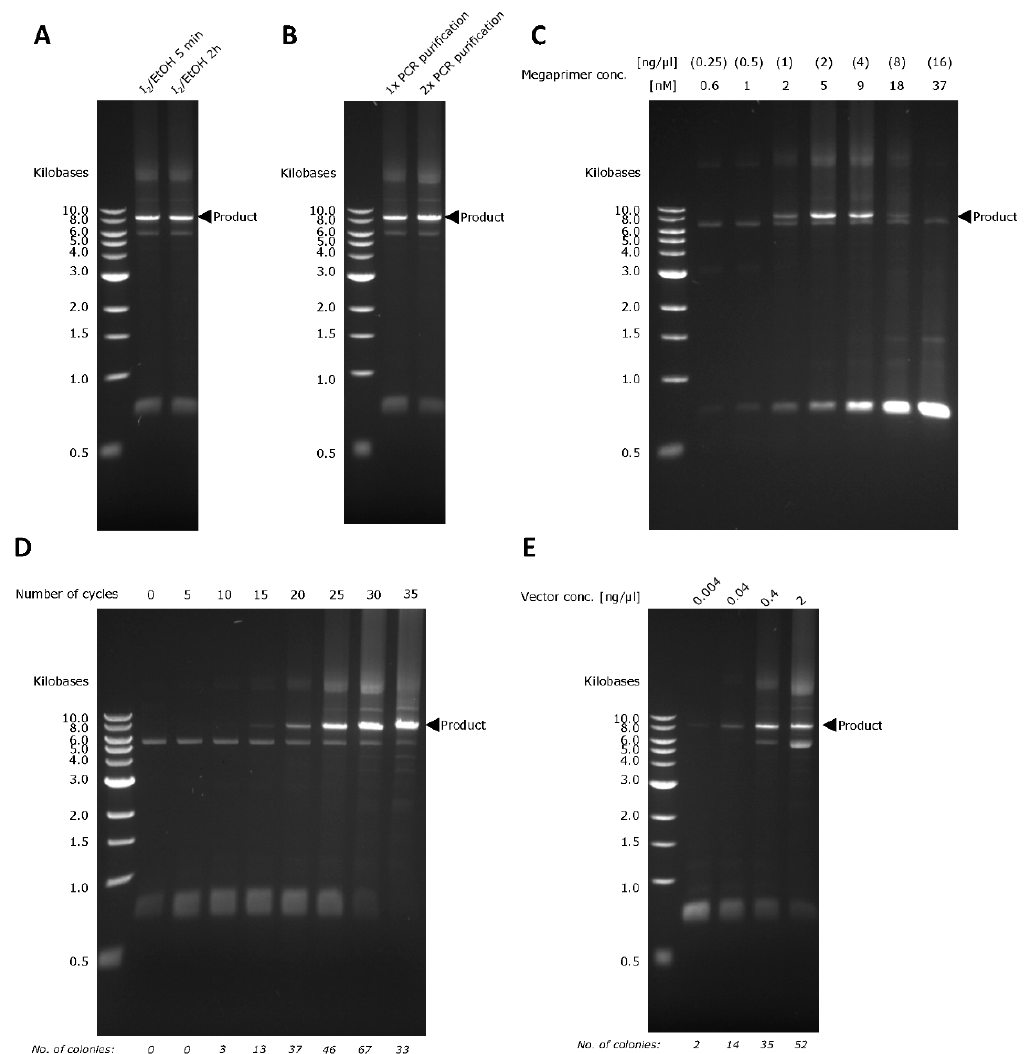
Figure 2. Optimization of PTO-QuickStep. The DNA gel shows the yield of megaprimer PCR ( A ) for di ff erent iodine cleavage times, ( B ) with and without an additional PCR purification step prior to iodine cleavage, ( C ) for di ff erent megaprimer concentrations, ( D ) for di ff erent number of PCR cycles, and ( E ) for di ff erent recipient plasmid concentrations.